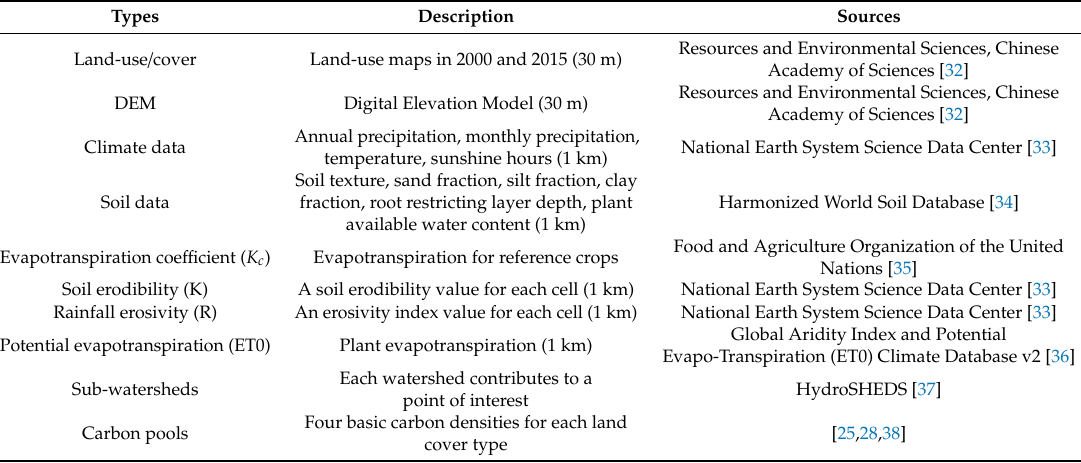
Table 1. Spatial data used in the InVEST